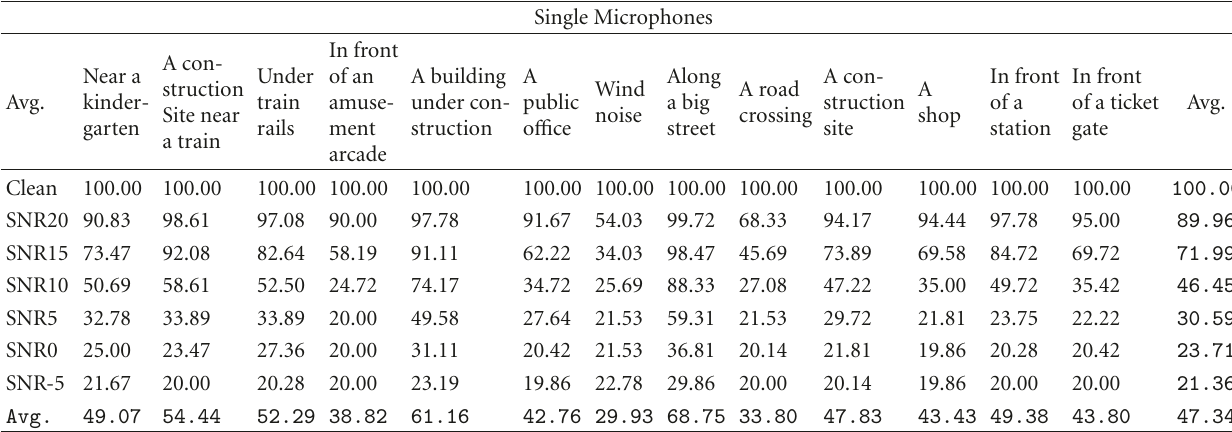
Table 1: Recognition accuracy of the single microphone.